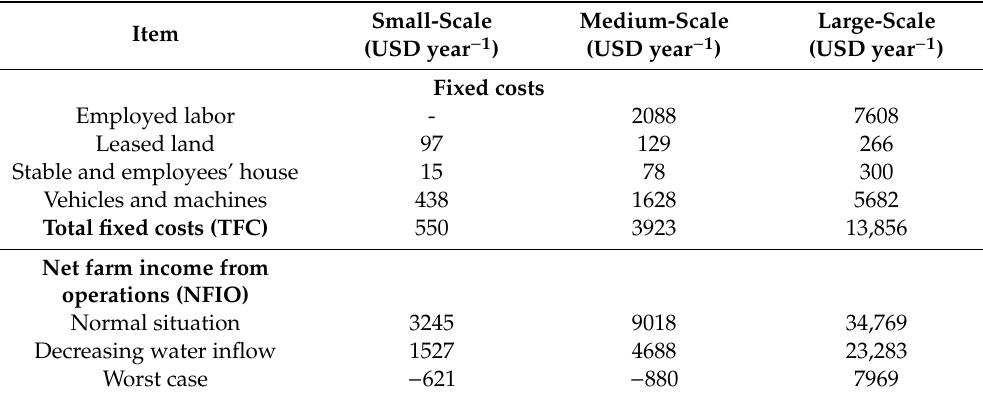
Figure 3. Contribution margin ratios for three types of individual farms in the Ili Delta under the three calculation scenarios: normal situation (light gray), decreasing water inflow (gray), and worst case (black). Table 9. Net farm income estimates of the three types of individual farms in the Ili Delta for the three calculation scenarios (base year